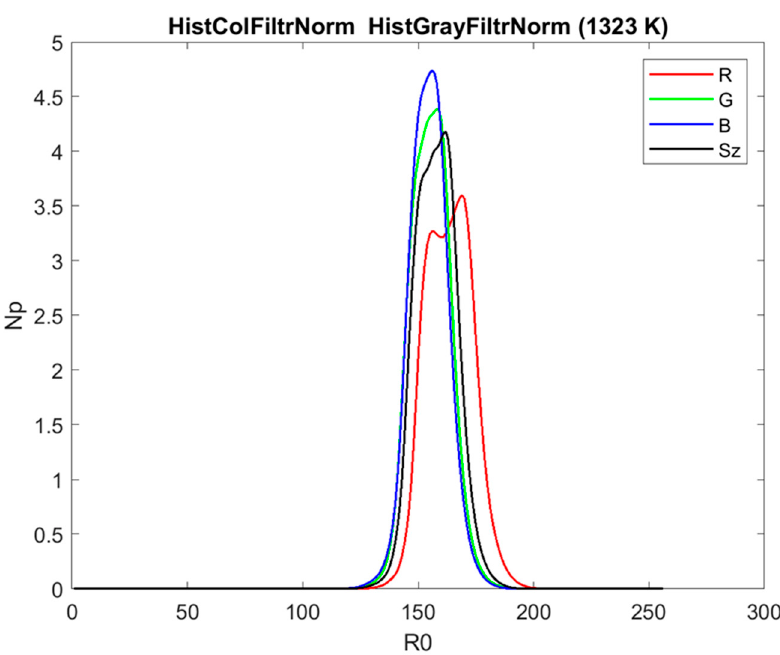
Figure 11. Normalized and smoothed R, G, B and Sz histograms for the blade No. 2 image (1323 K). The average values of histograms of RGB components (R, G, B), grayscale Sz and Sum = (R + G + B)/3 as a function of blade heating temperature are presented in Figure 12.